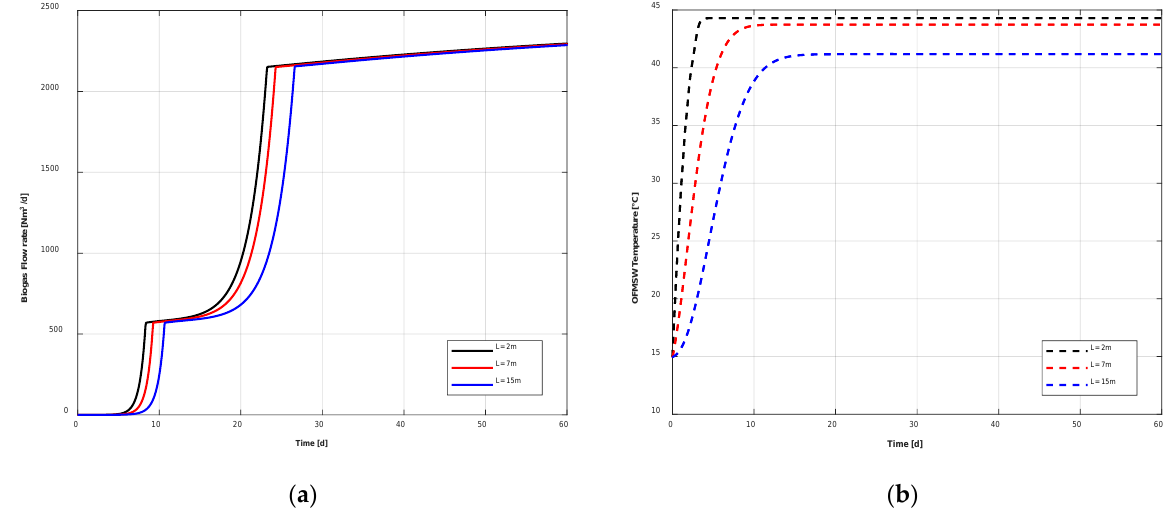
Figure 6. Volumetric biogas flow rate ( a ) and output OFMSW Temperature ( b ) in different positions of the PFR.